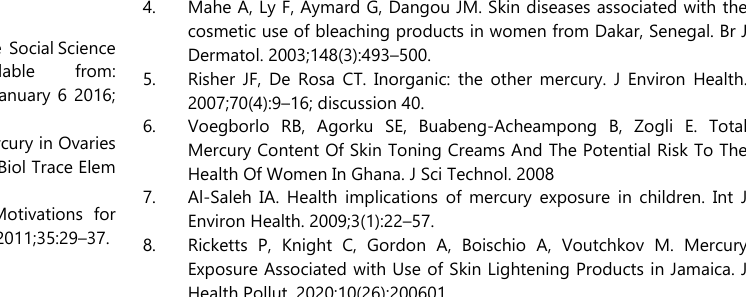
Table 2. Urinary mercury levels and their clinical relevance. Urinary mercury level (µg of HG/L of urine)